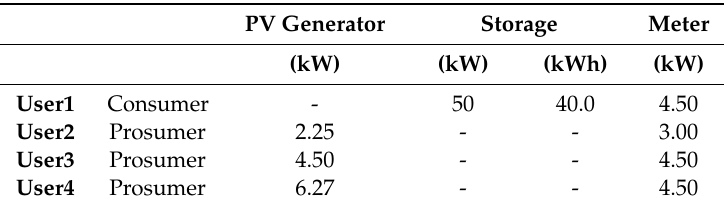
Table 1. Technical